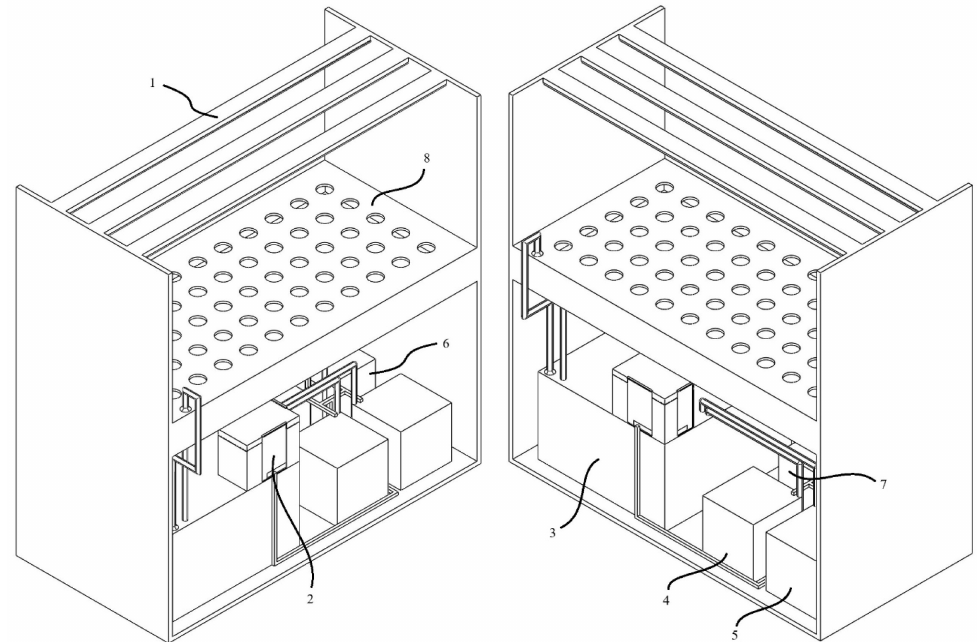
Figure 3. Positioning of the hydroponic system and the kit. (1) Artificial lighting unit; (2) the kit obtained as a result of the project; (3) liquid reservoir; (4) EC-increasing fertilizer solution; (5) pH- increasing solution; (6) EC-lowering solution; (7) pH-lowering solution; (8) cultivation